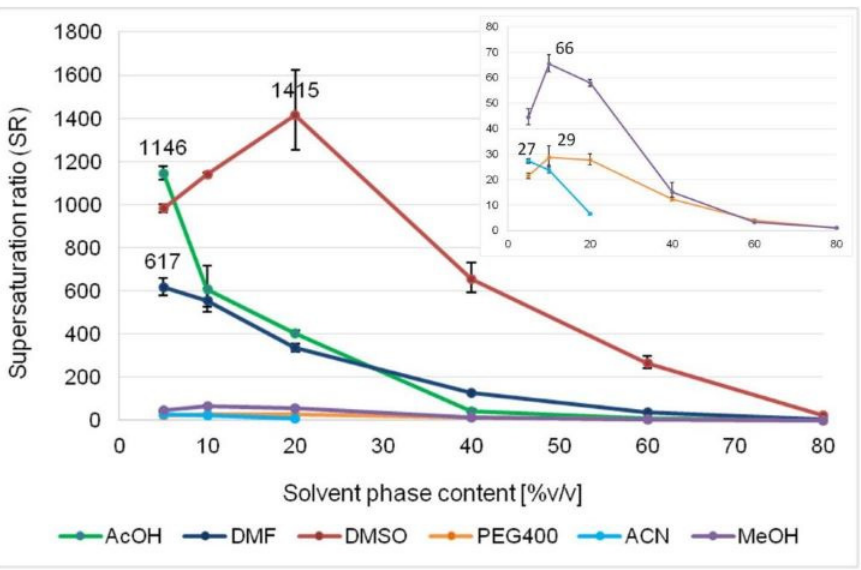
Figure A1. Cilostazol supersaturation ratios at different compositions of organic solvents and water.